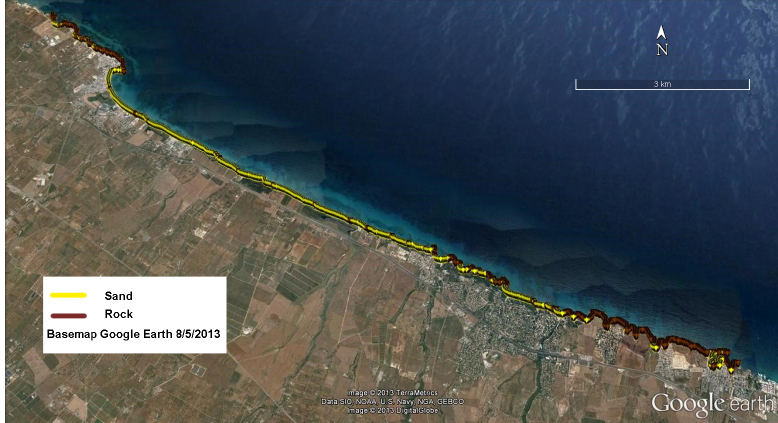
Figure 4. Coastal type classification over Test site I: rocky and sandy stretches are marked in brown and yellow, respectively.